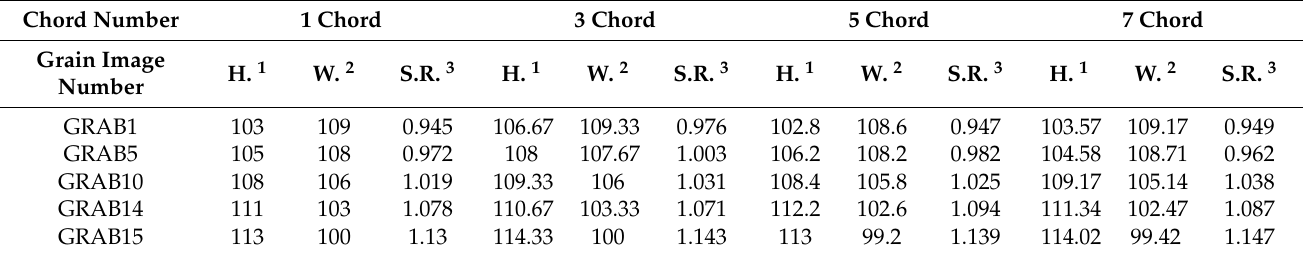
Table 3. The multi-chord grain fitting data and shape parameters (grain 3).